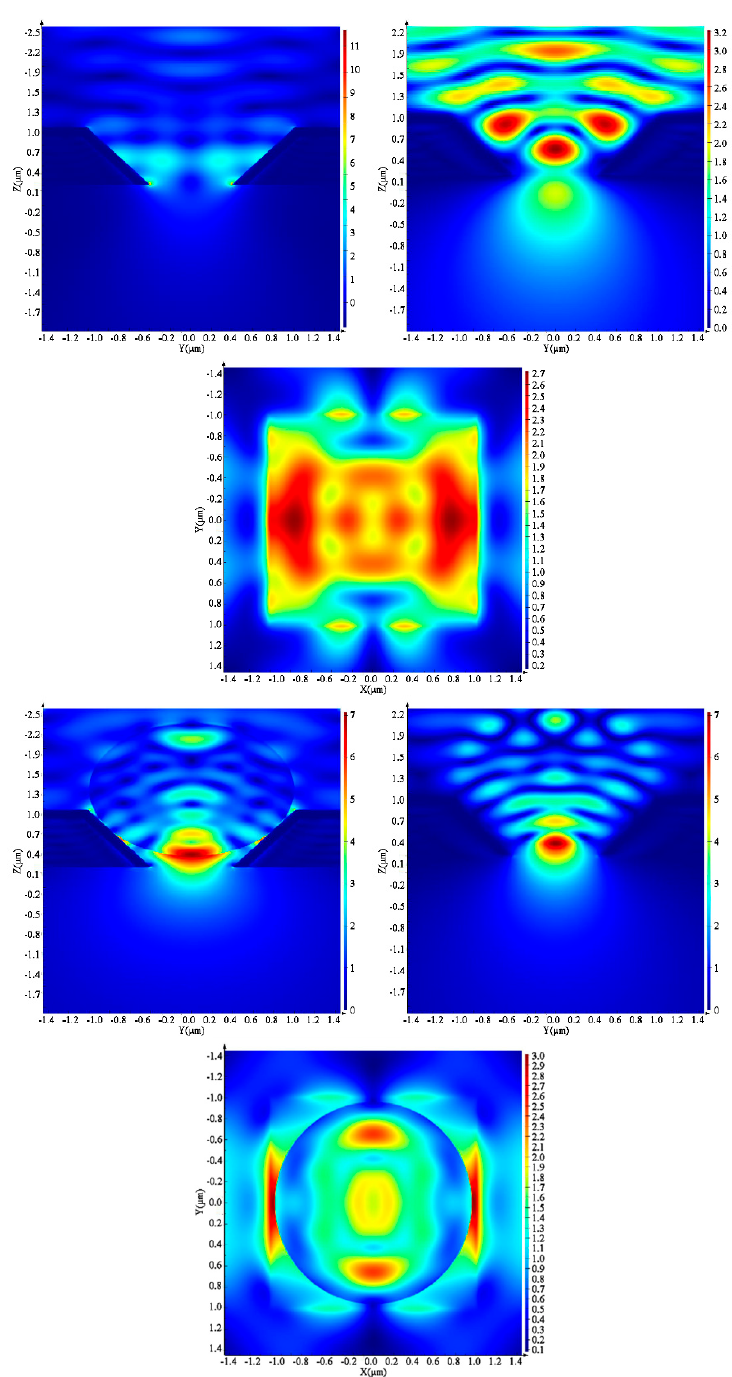
Figure 4. Simulated near-field intensity distribution of gold-coated perforated inverse pyramid without (upper row) and with (lower row) a trapped polymer microparticle in different planes.